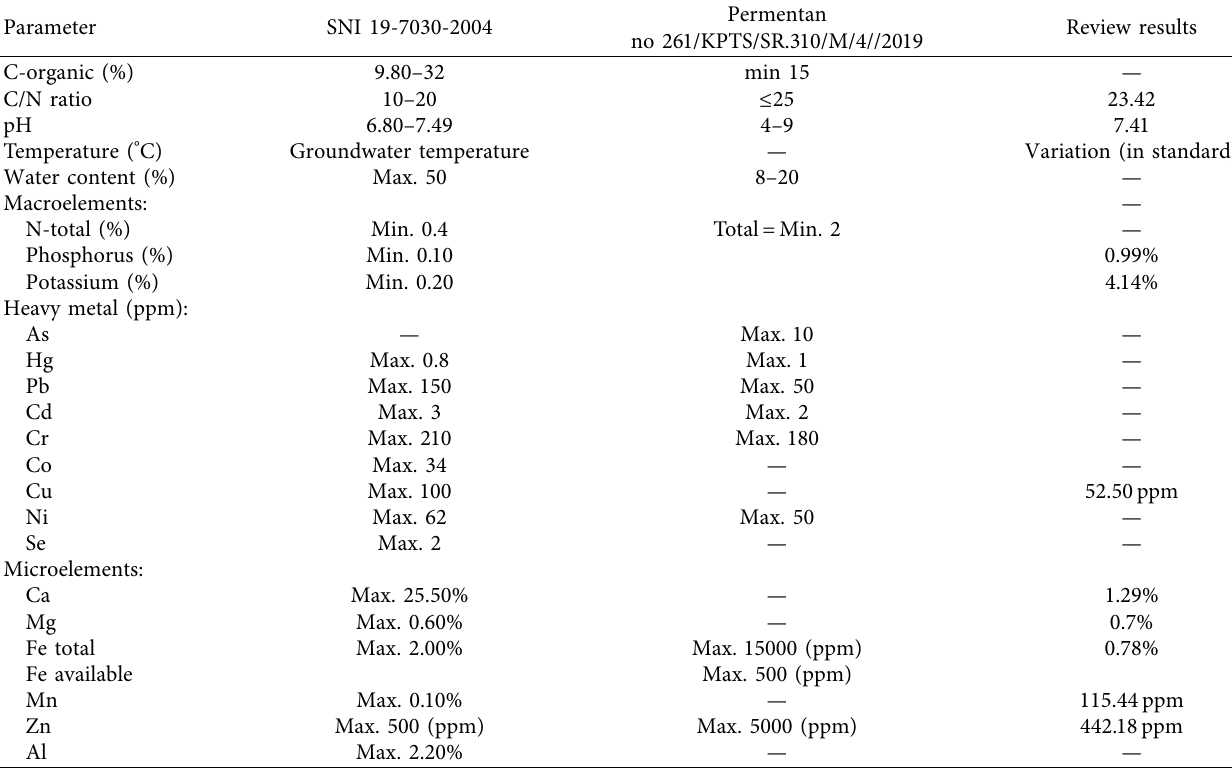
Table 4: Comparison of review data of compost standards based on the Indonesian standards (SNI 19-7030-2004) and Minister of Agriculture (Regulation No.